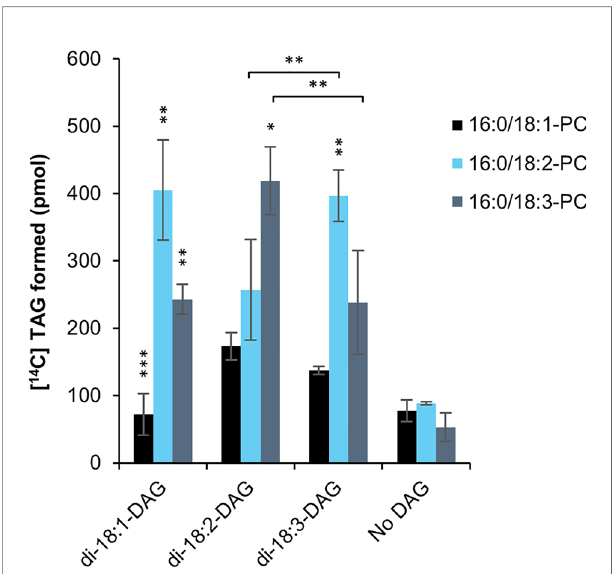
FIGURE 4 | Substrate speci fi cities of C. sativa PDAT in microsomal preparations of from developing seeds overexpressing the enzyme, when fed [ 14 C]radiolabeled PC and different DAG. Stars over individual bars indicate signi fi cant differences compared to the other PC species with the same DAG according to one-way ANOVA followed by Tukey ’ s test performed on the whole dataset. *p ≤ 0.05, **p ≤ 0.01, ***p ≤ 0.001. Stars at lines between bars indicate signi fi cant differences between selected PC and DAG species further discussed. Complete results of the statistical analysis can be found in Supplementary Table 4 . Average value shown ± SD, n = 3